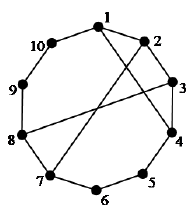
Figure 3. An example 10-link 1-DOF kinematic chain.